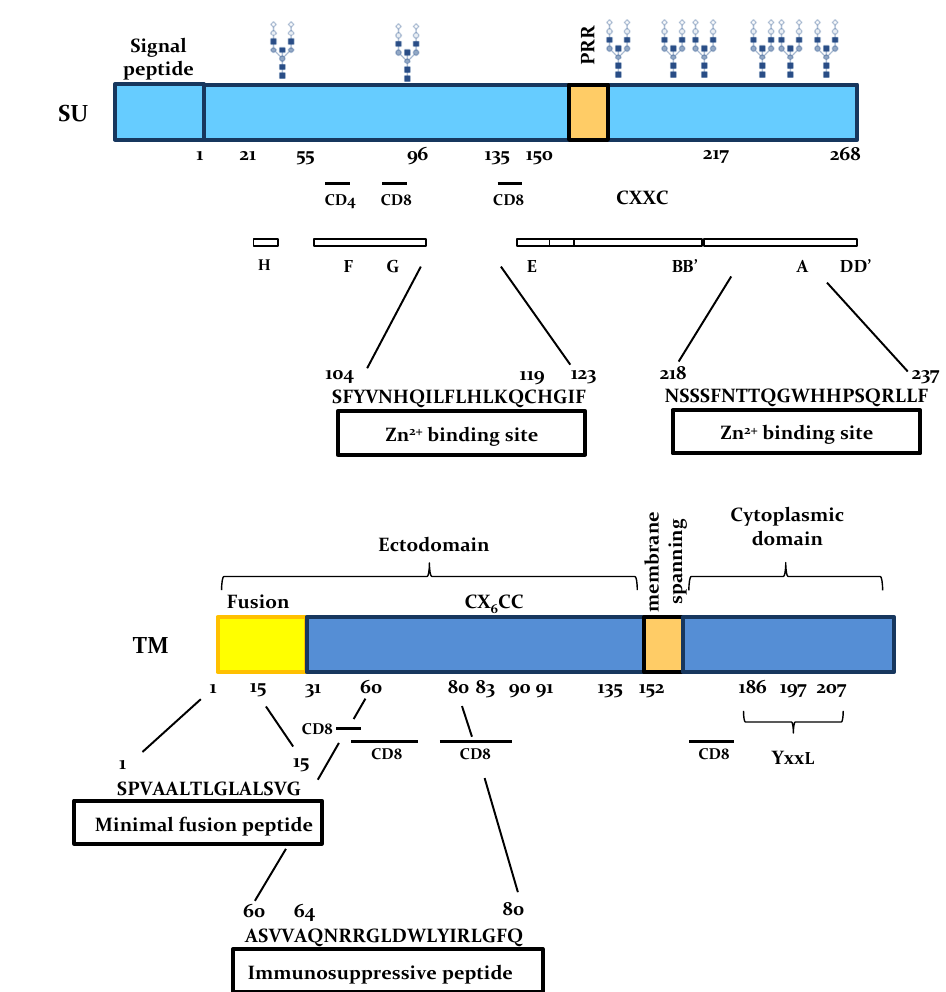
Figure 2. Schematic representation of the SU and TM envelope proteins. ( a ) Major domains of BLV SU are indicated: potential N -glycosylation sites (glycan trees), antigenic peptides targeted by monoclonal antibodies (A-H), CD4 epitope at amino acid 61–70 and CD8 epitopes respectively located at position 73–92 and 131–140 in the SU protein and at amino acid 40–59; 50–69; 70–89 and 150–169 in the TM part, a proline-rich region (PRR) and two zinc-binding regions (Zn 2+ ). Numbers are amino acid coordinates of SU after signal peptide cleavage (green); ( b ) The TM protein has two hydrophobic regions: a fusion peptide (yellow) and a membrane-spanning domain (orange) that anchors the SU-TM complex into lipid bilayers. Other TM domains are: the immunosuppressive peptide, immunoreceptor tyrosine-based (YxxL) activation motifs (ITAM) and cysteines (C) involved in disulfide bonds between SU and TM.